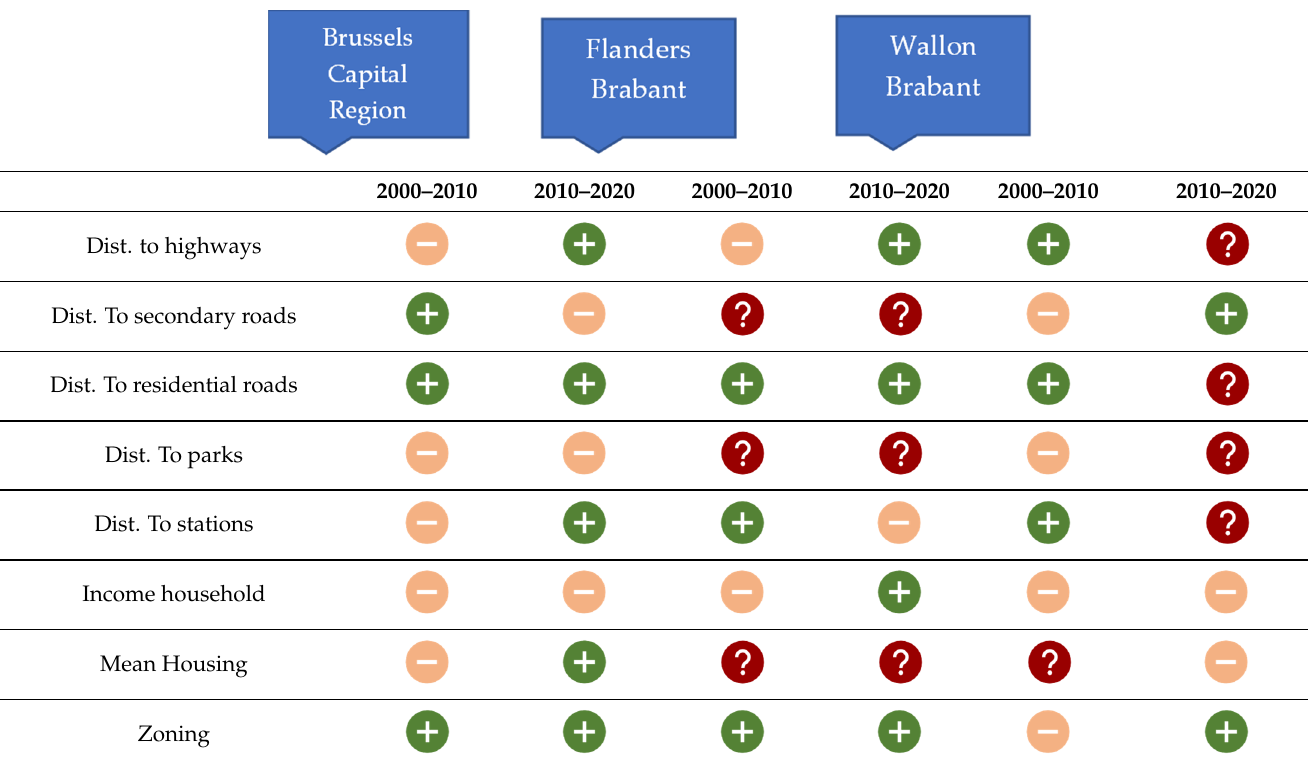
Table 3. Summary of selected significant drivers with their impact on densification over time and region.